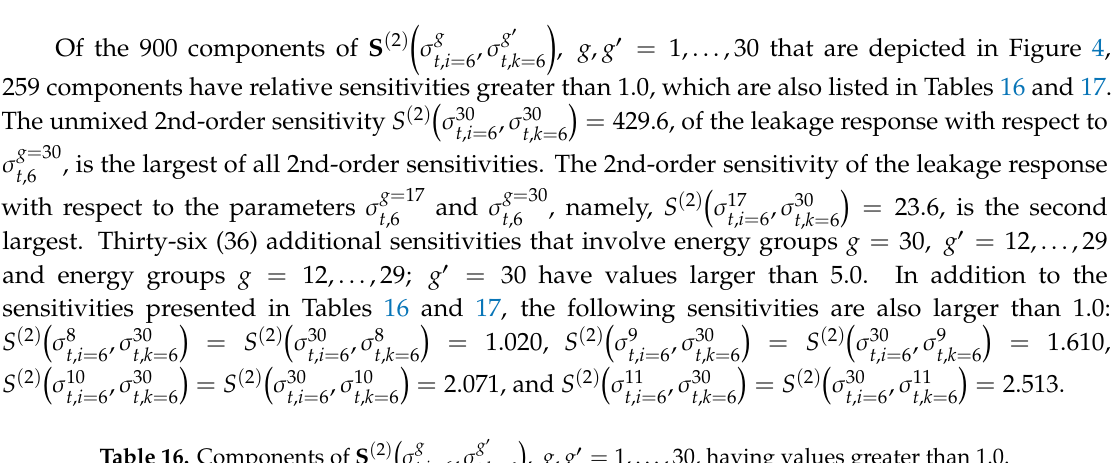
Table 16. Components of S ( 2 )